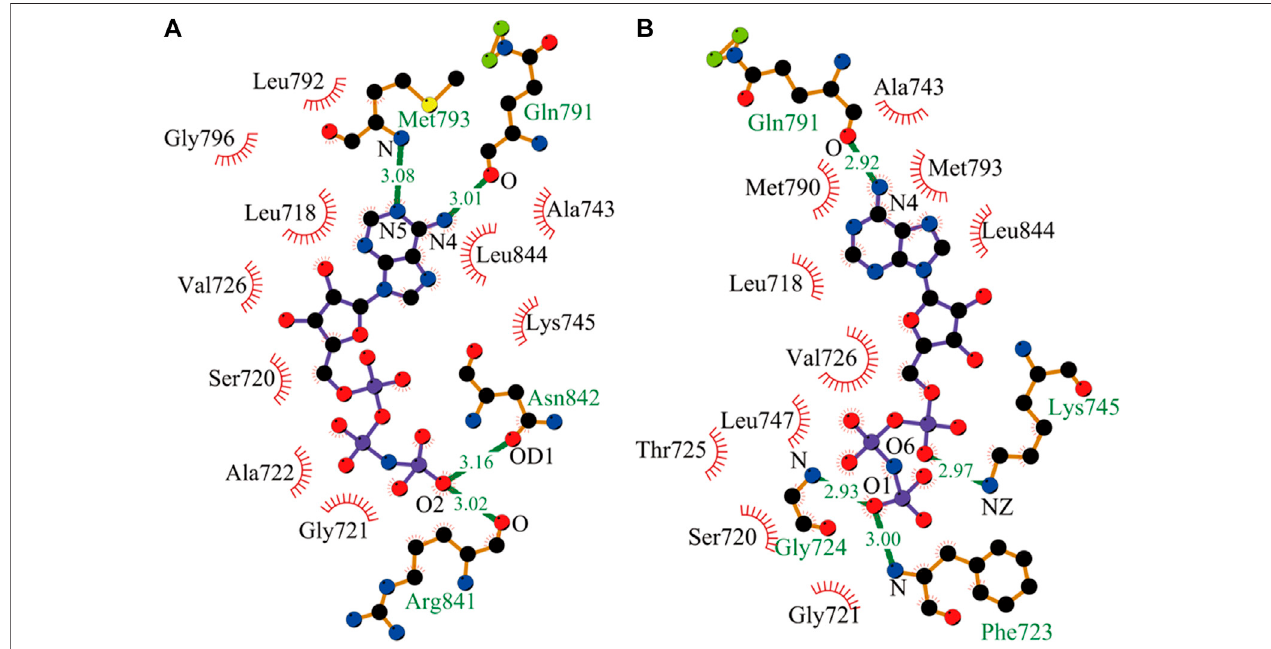
FIGURE 1 | Interactions of AMP with its nearby residues in EGFR mutants, plotted by LIGPLOT. (A) Analysis of hydrogen bond and hydrophobic interaction of binding interface in the L858R mutant. (B) The L858R/T790M mutant (Wallace et al., 1995; Laskowski and Swindells,